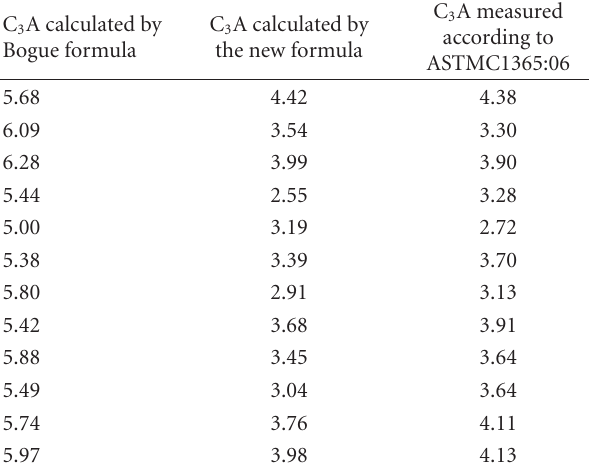
Table 2: Comparison of the C 3 A